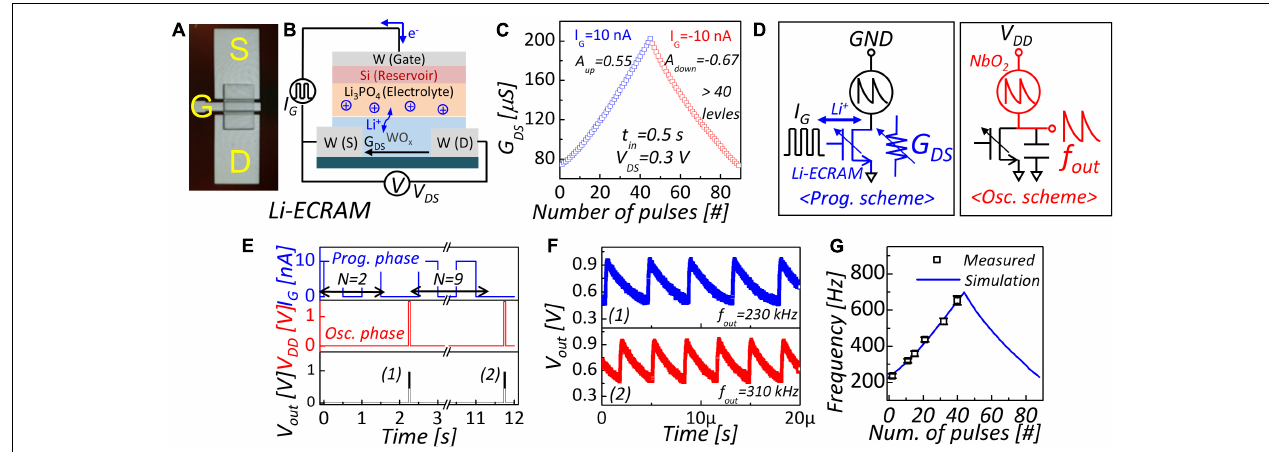
FIGURE 4 | (A) Optical microscope image and (B) device structure of Li-ECRAM. (C) Conductance response to identical pulses. Low non-linearity (A up = 0.55, A down = − 0.67) is obtained. (D) Frequency programming scheme and oscillator scheme of NbO 2 -based oscillator with Li-ECRAM. (E) Real-time measurement of oscillation frequency modulation. N represents applied number of pulses in programming scheme. (F) Magnified figure of output waveform in (E) . (G) Frequency modulation with applied number of pulses.